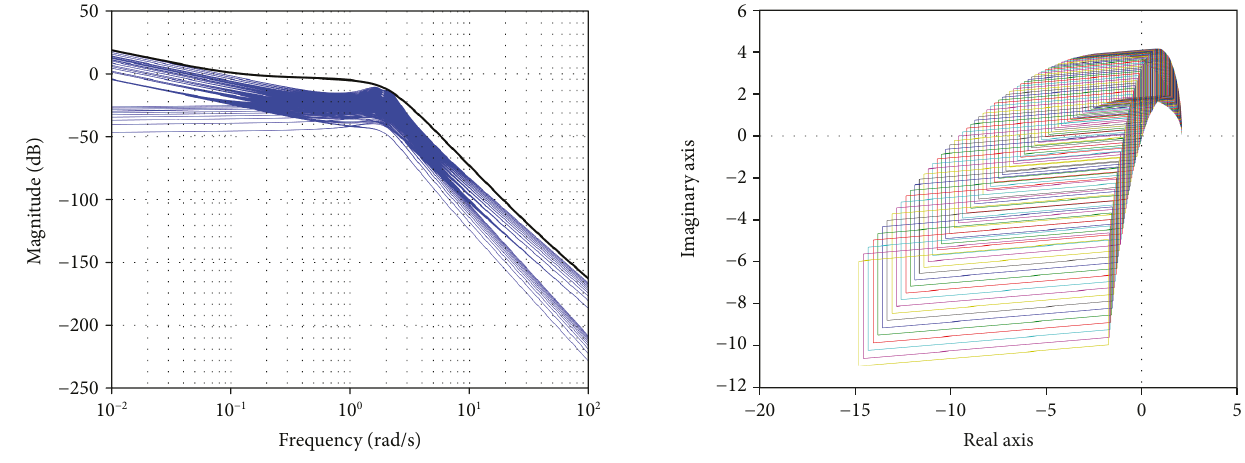
Figure 9: Bode magnitude plots — set of FO perturbations and weight function (28) for the additive uncertainty model.